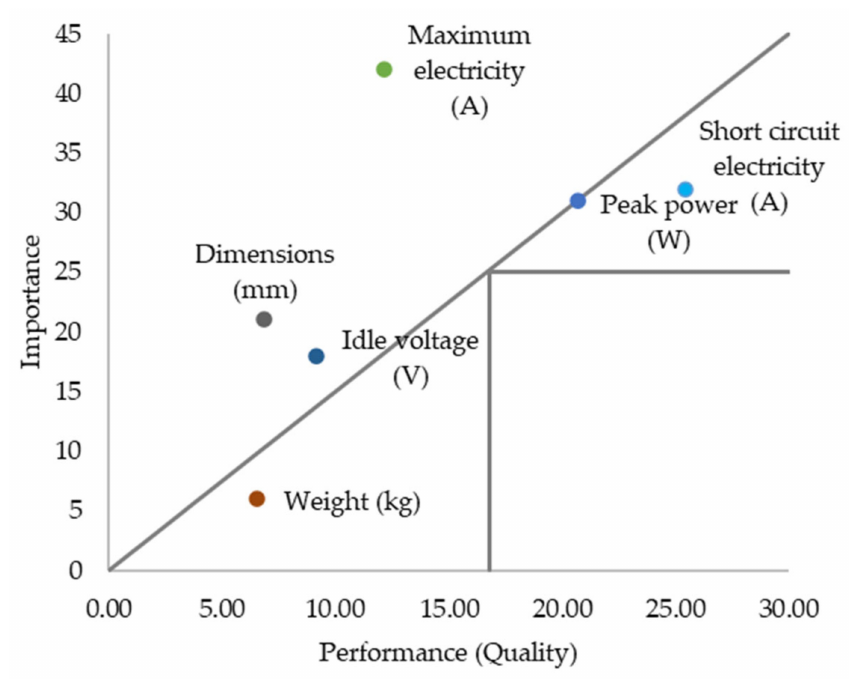
Figure 5. IPA chart for PV